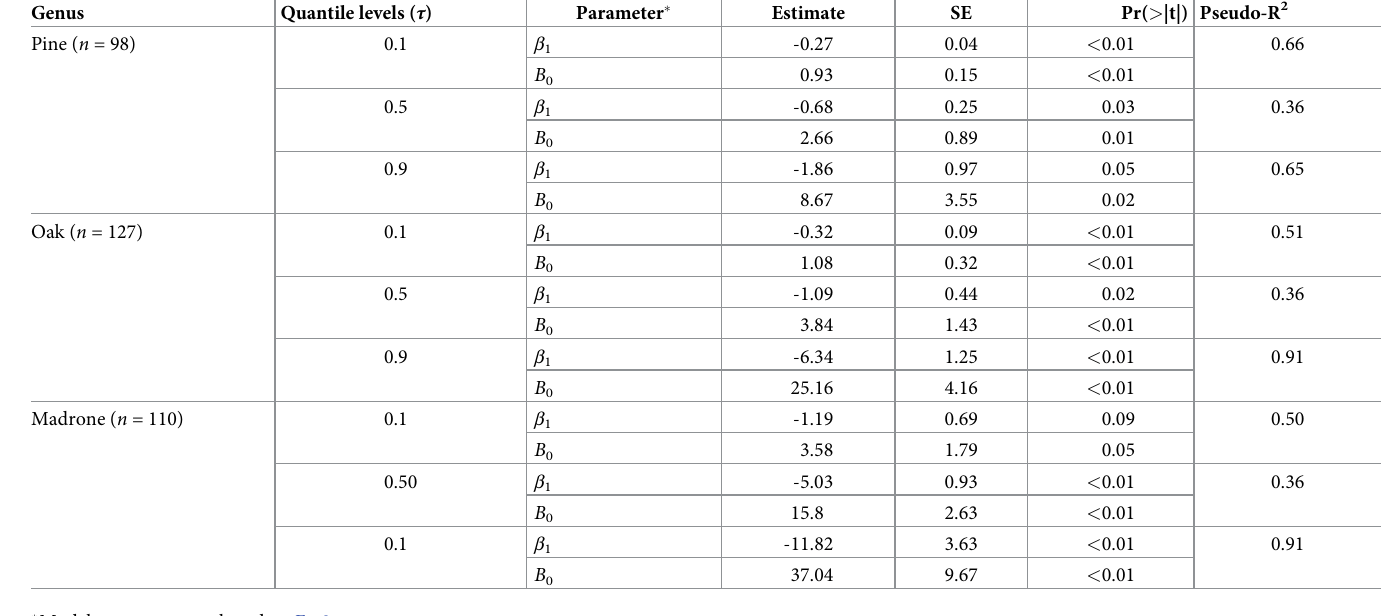
Table 2. Quantile regression estimates and goodness-of-fit statistics for the relationship between stemflow funneling ratio and diameter at breast height (cm) in Molinillos, Mexico. Genus Quantile levels ( τ